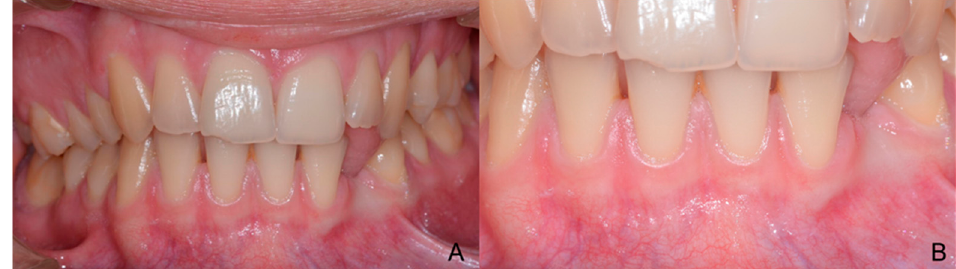
Figure 10. Series of images from cone beam computed tomography (CBCT) prior to the surgery. ( A ) The crown of the impacted canine 33 deforms the vestibular profile of the mandible; ( B , C ) Parasagittal images of the odontoma; ( D ) Parasagittal images, the canine can be seen in the vestibular position; ( E ) Three-dimensional reconstruction confirms the position of the canine which is at the level of the right central incisor 41; ( F ) Detail of the orthopanoramic image, showing the position of the canine in close contact with the root apexes of the central incisors, 41 and 31, and also partially of the lateral ones, 32 and 42.